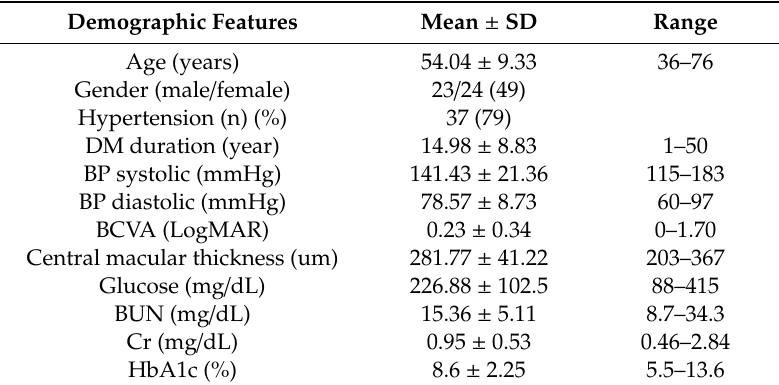
Table 1. Demographic and clinical features of enrolled subjects.